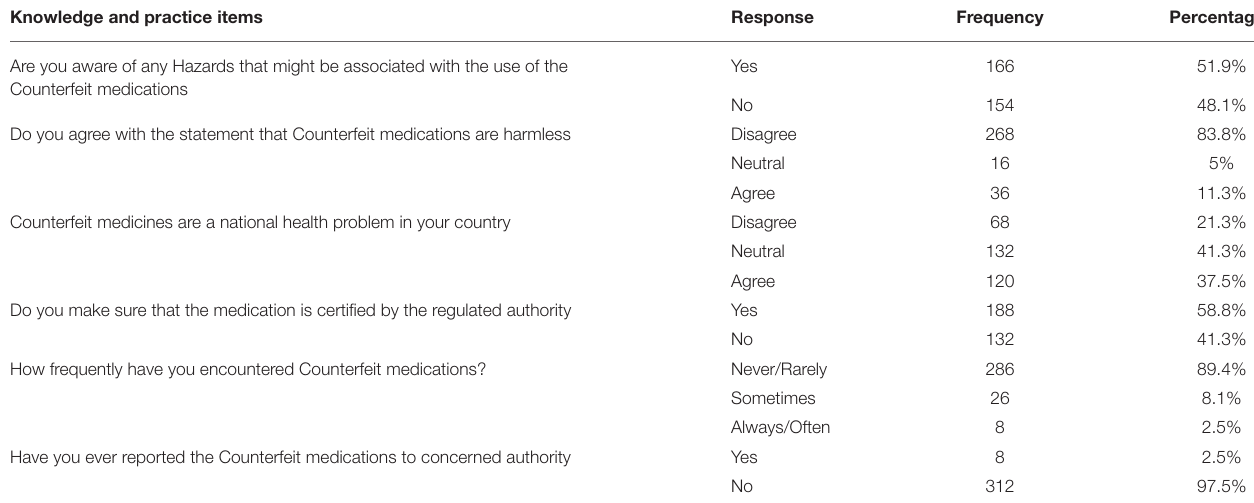
TABLE 2 | Frequency table for knowledge and practice items.